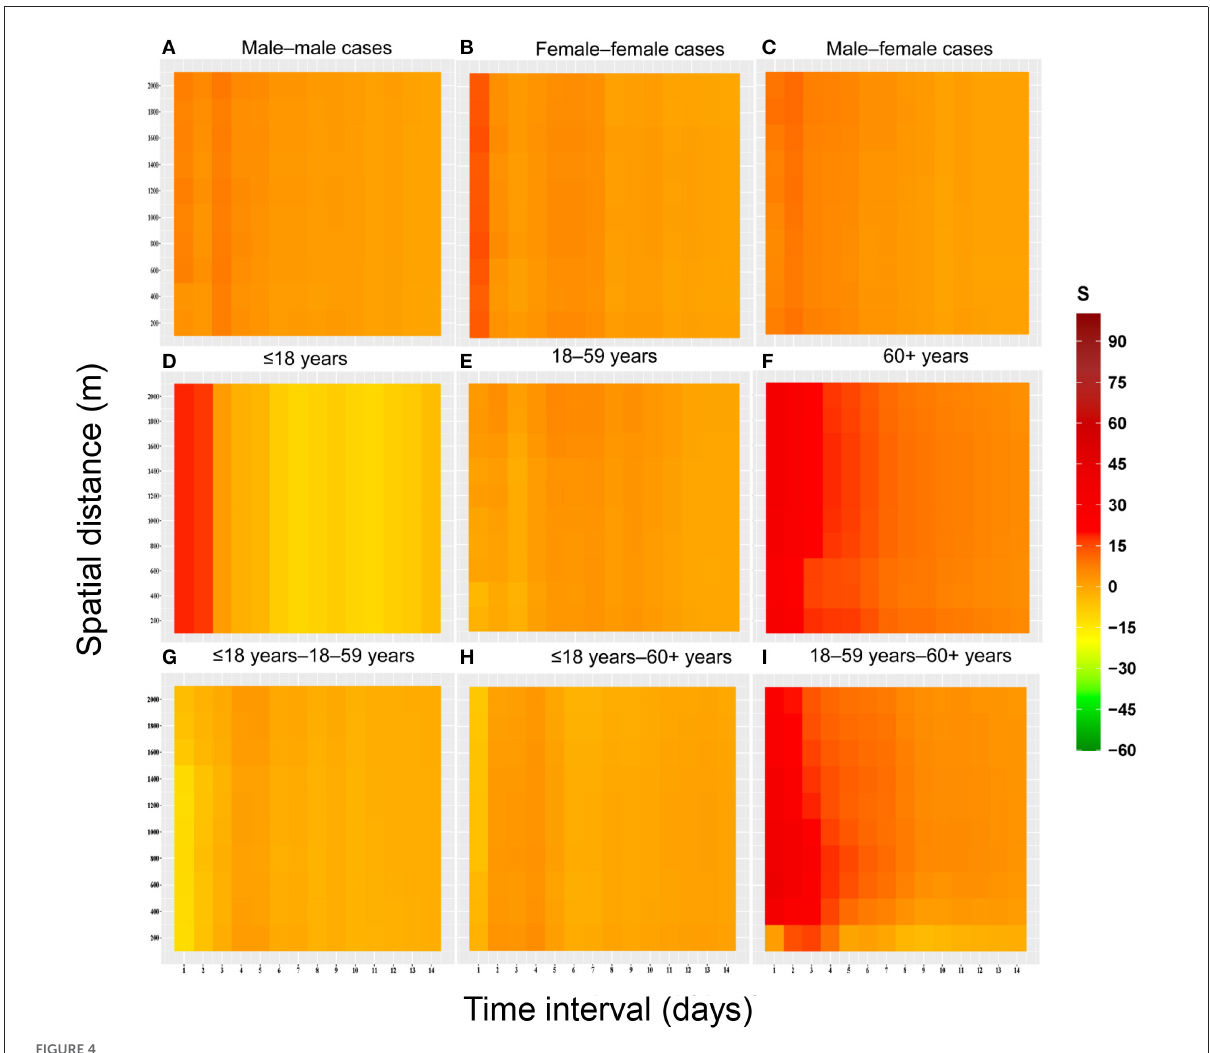
FIGURE4 Heat map of spatial-temporal clustering due to space-time interactions among populations with different characteristics for the COVID-19 epidemic in Guangzhou from May to June 2021. (A) Male–male cases. (B) Female–female cases. (C) Male–female cases. (D) ≤ 18 years.